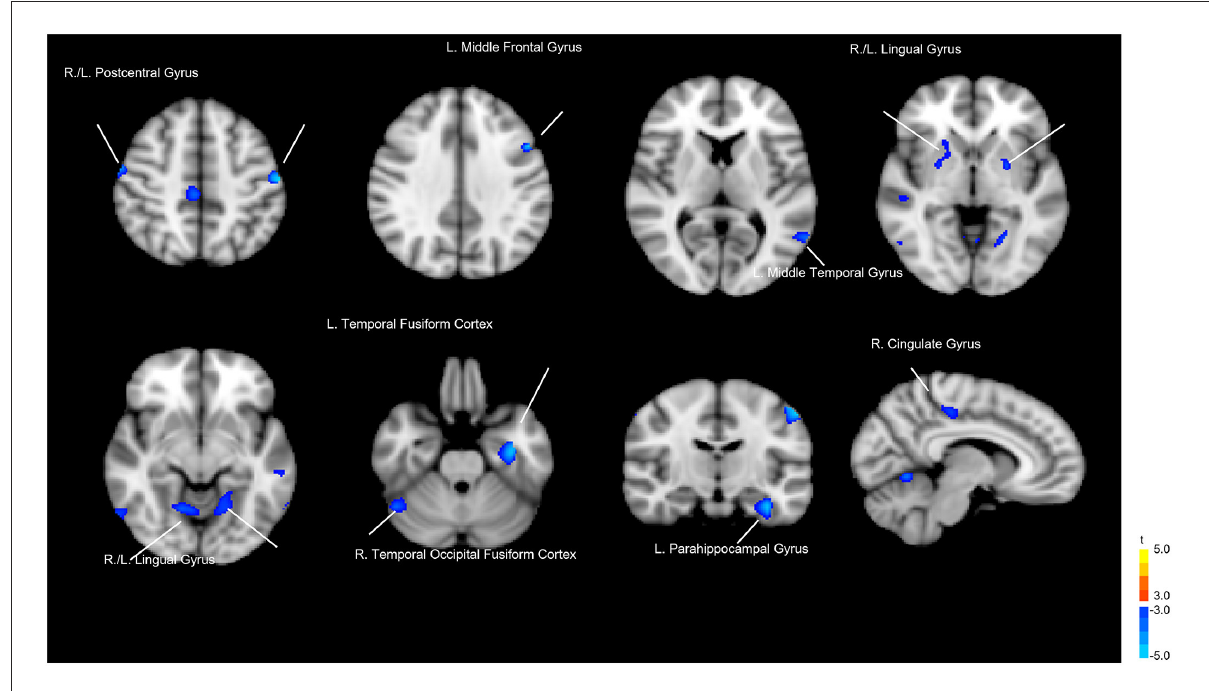
FIGURE1 Gray matter volume differences between the patients with late-life depression (LLD) and healthy controls. Blue areas indicate brain regions where gray matter volume was significantly